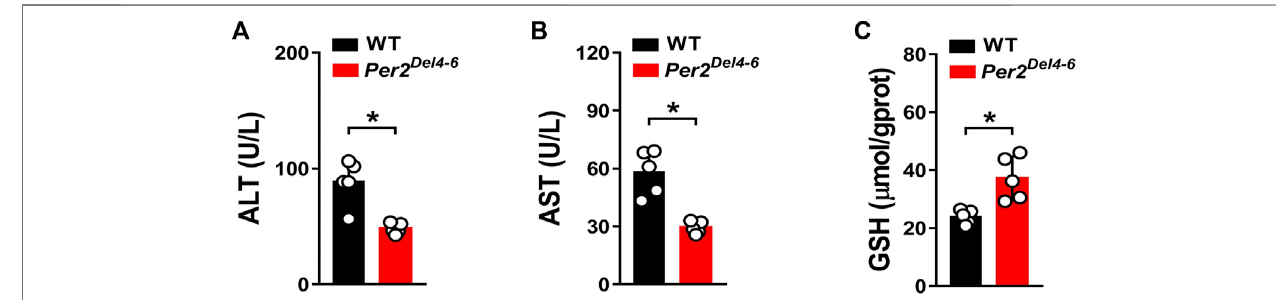
FIGURE 5 | Characterization of CPA-induced hepatotoxicity in Per2 Del4-6 mice. (A) Plasma ALT levels in Per2 Del4-6 and WT mice at 4 h after CPA administration (i.p., 100 mg/kg, n (cid:1) 5). (B) Plasma AST levels in Per2 Del4-6 and WT mice at 4 h after CPA administration. (C) Hepatic GSH levels in Per2 Del4-6 and WT mice at 4 h after CPA administration. Data are mean ± SD ( n (cid:1) 5). * p < 0.05 (t test).